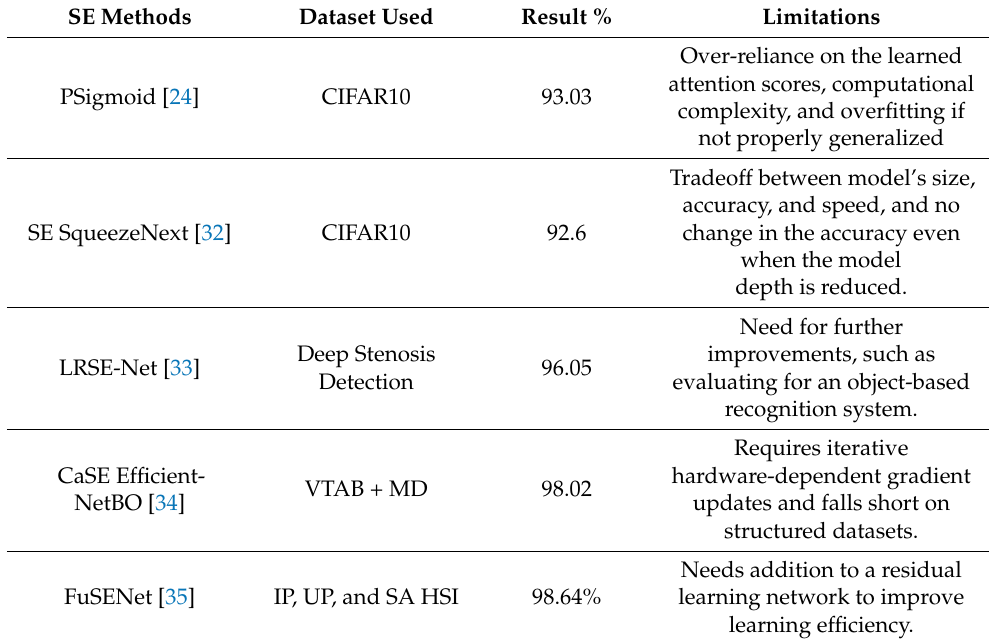
Table 1. Summary of various SE